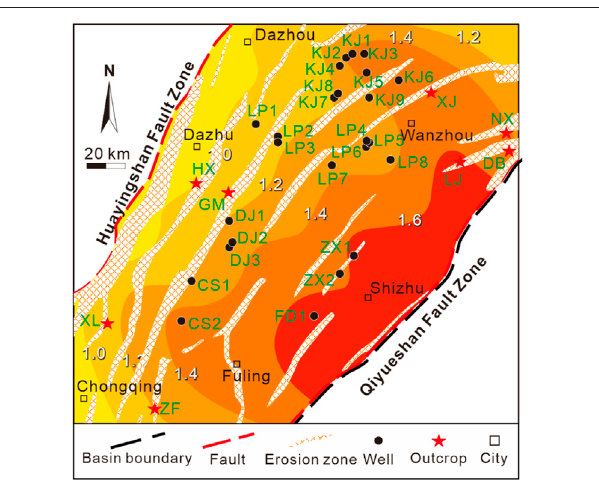
FIGURE 10 | Contour map shows the R o for black shale in the Dongyuemiao member.